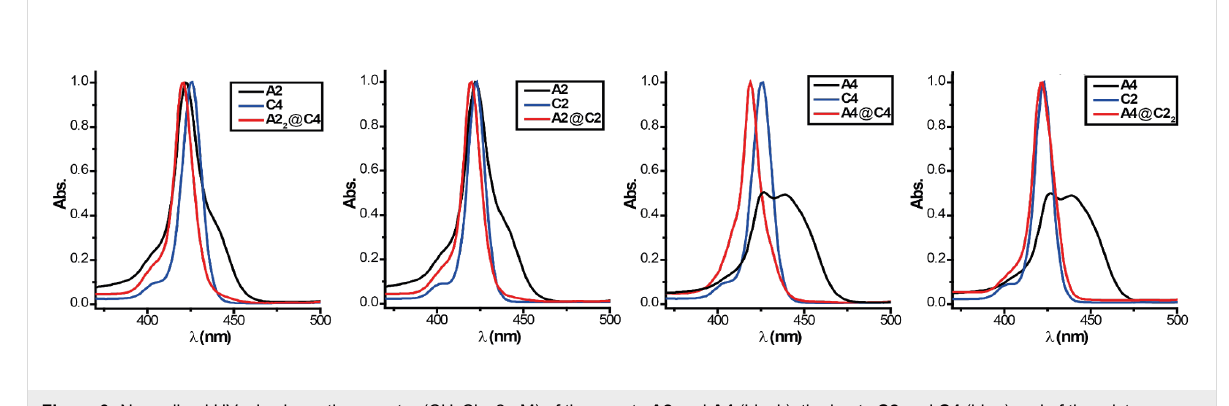
Figure 9: Normalized UV–vis absorption spectra (CH 2 Cl 2 , 2 μ M) of the guests A2 and A4 (black), the hosts C2 and C4 (blue) and of the mixtures (red), showing a slight hypsochromic shift of the absorption maxima upon complexation.